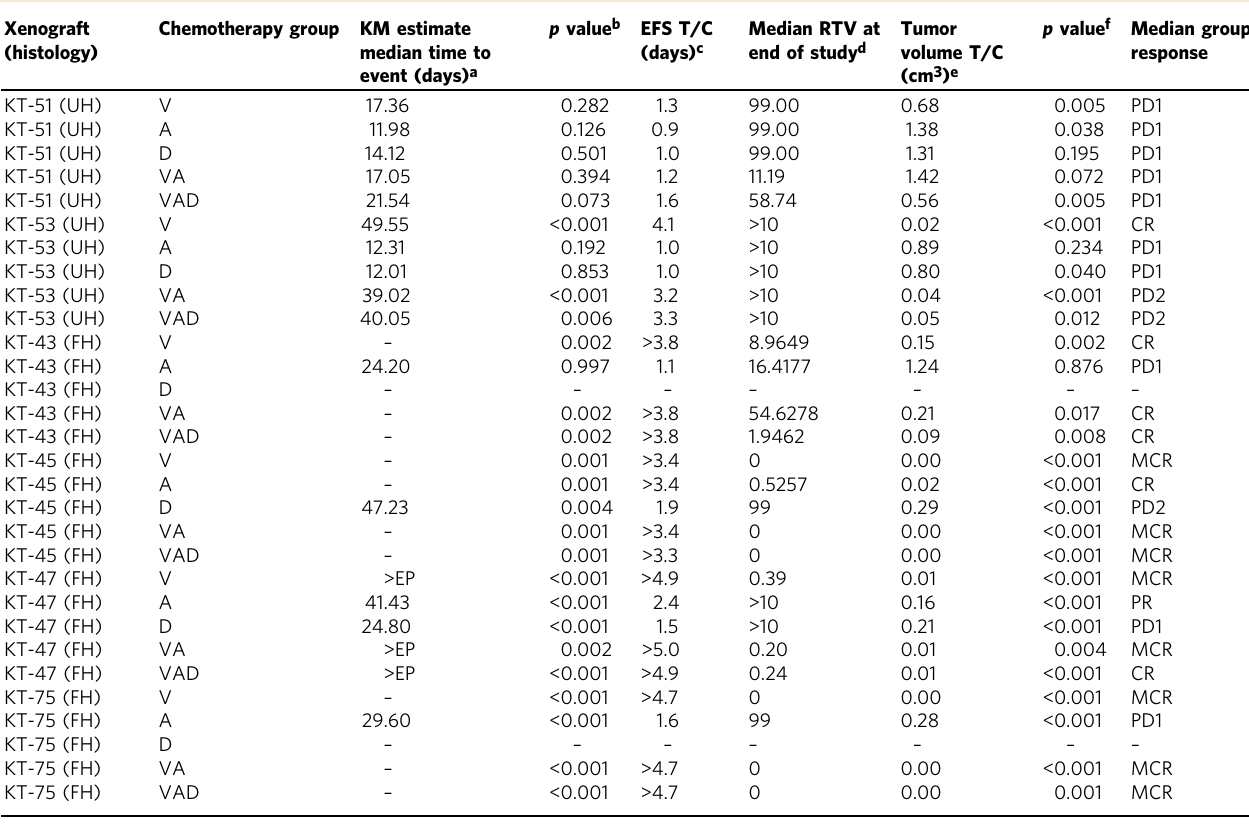
Table 1 Treatment response of xenografts